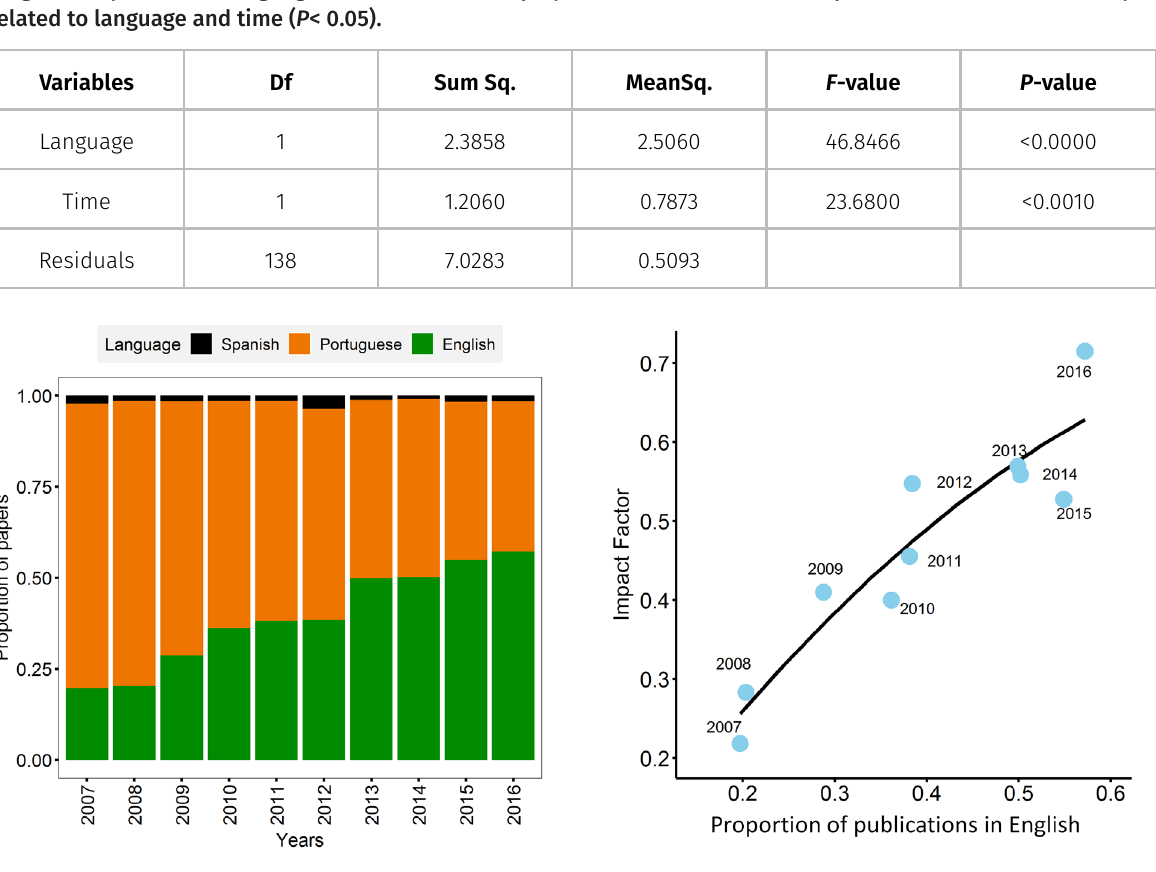
Figure 3. Positive relationship between the mean impact factor of selected multilanguage journals and the proportion of papers published in English per